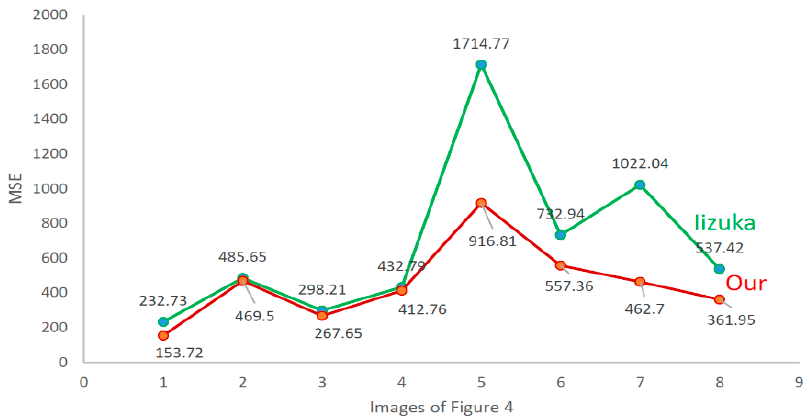
Figure 5. The MSE result pairs of our method and Iizuka’s method on images of Figure 4.